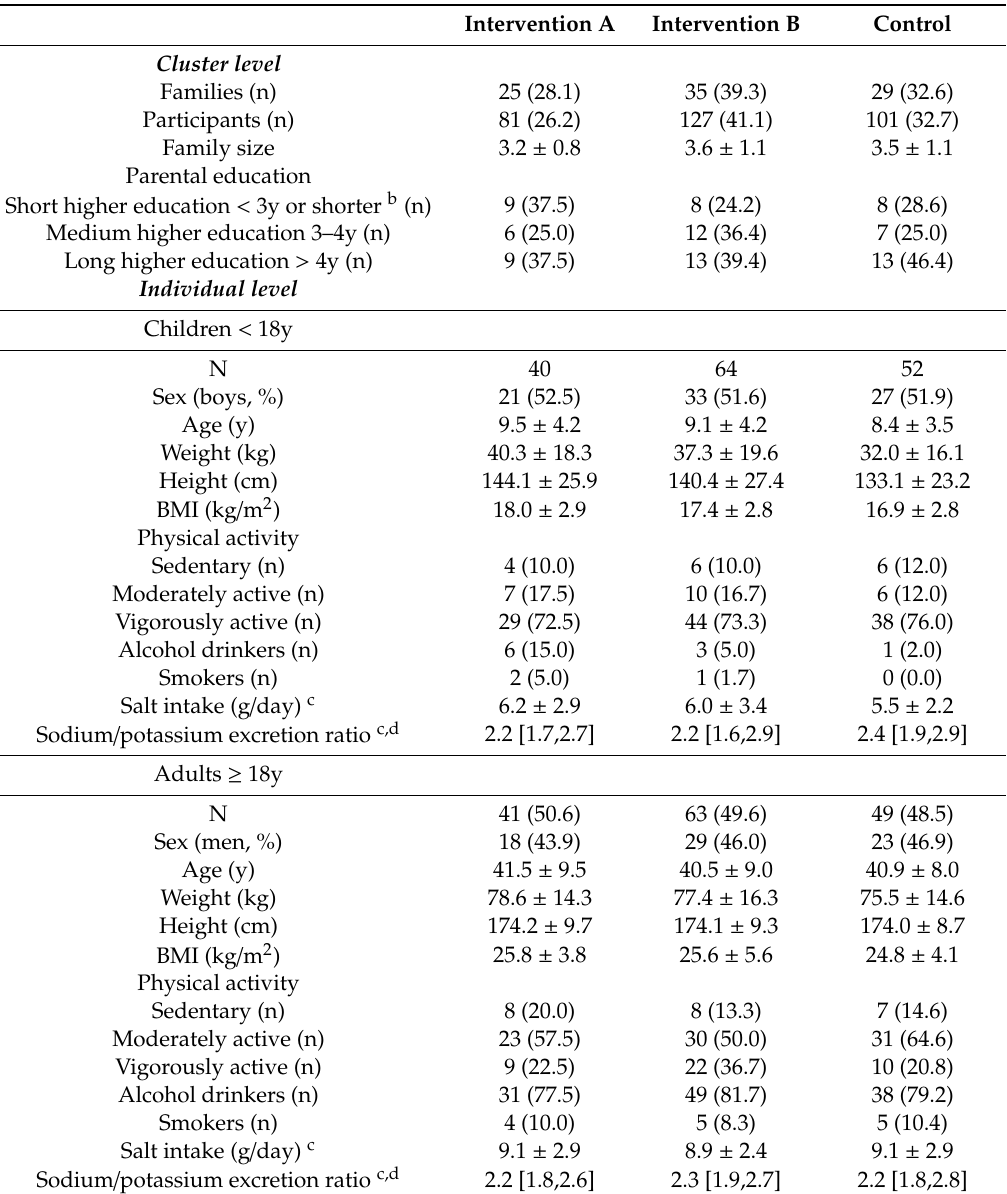
Table 1. Baseline characteristics at cluster- and individual level a